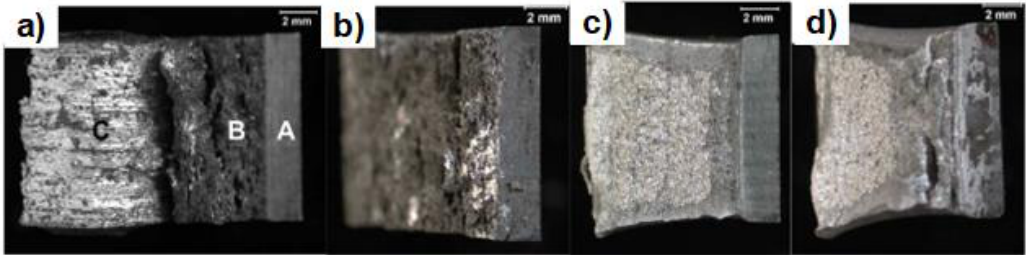
Figure 2. Fracture surfaces of the specimens after the Charpy impact test (+20 °C): ( a ) puddle iron in post-operated state (A–notch zone, B–crack propagation area, C–the plastic zone from the bottom part of the Charpy specimen), ( b ) puddle iron after heat treatment (normalized), ( c ) early 20th-century mild steel, post-operated state, ( d ) early 20th century mild steel, normalized state. As shown in Figure 2, the differences in ductility were noticeable for both long-term operated materials. As reported in several papers devoted to the degradation of long-term operated materials,